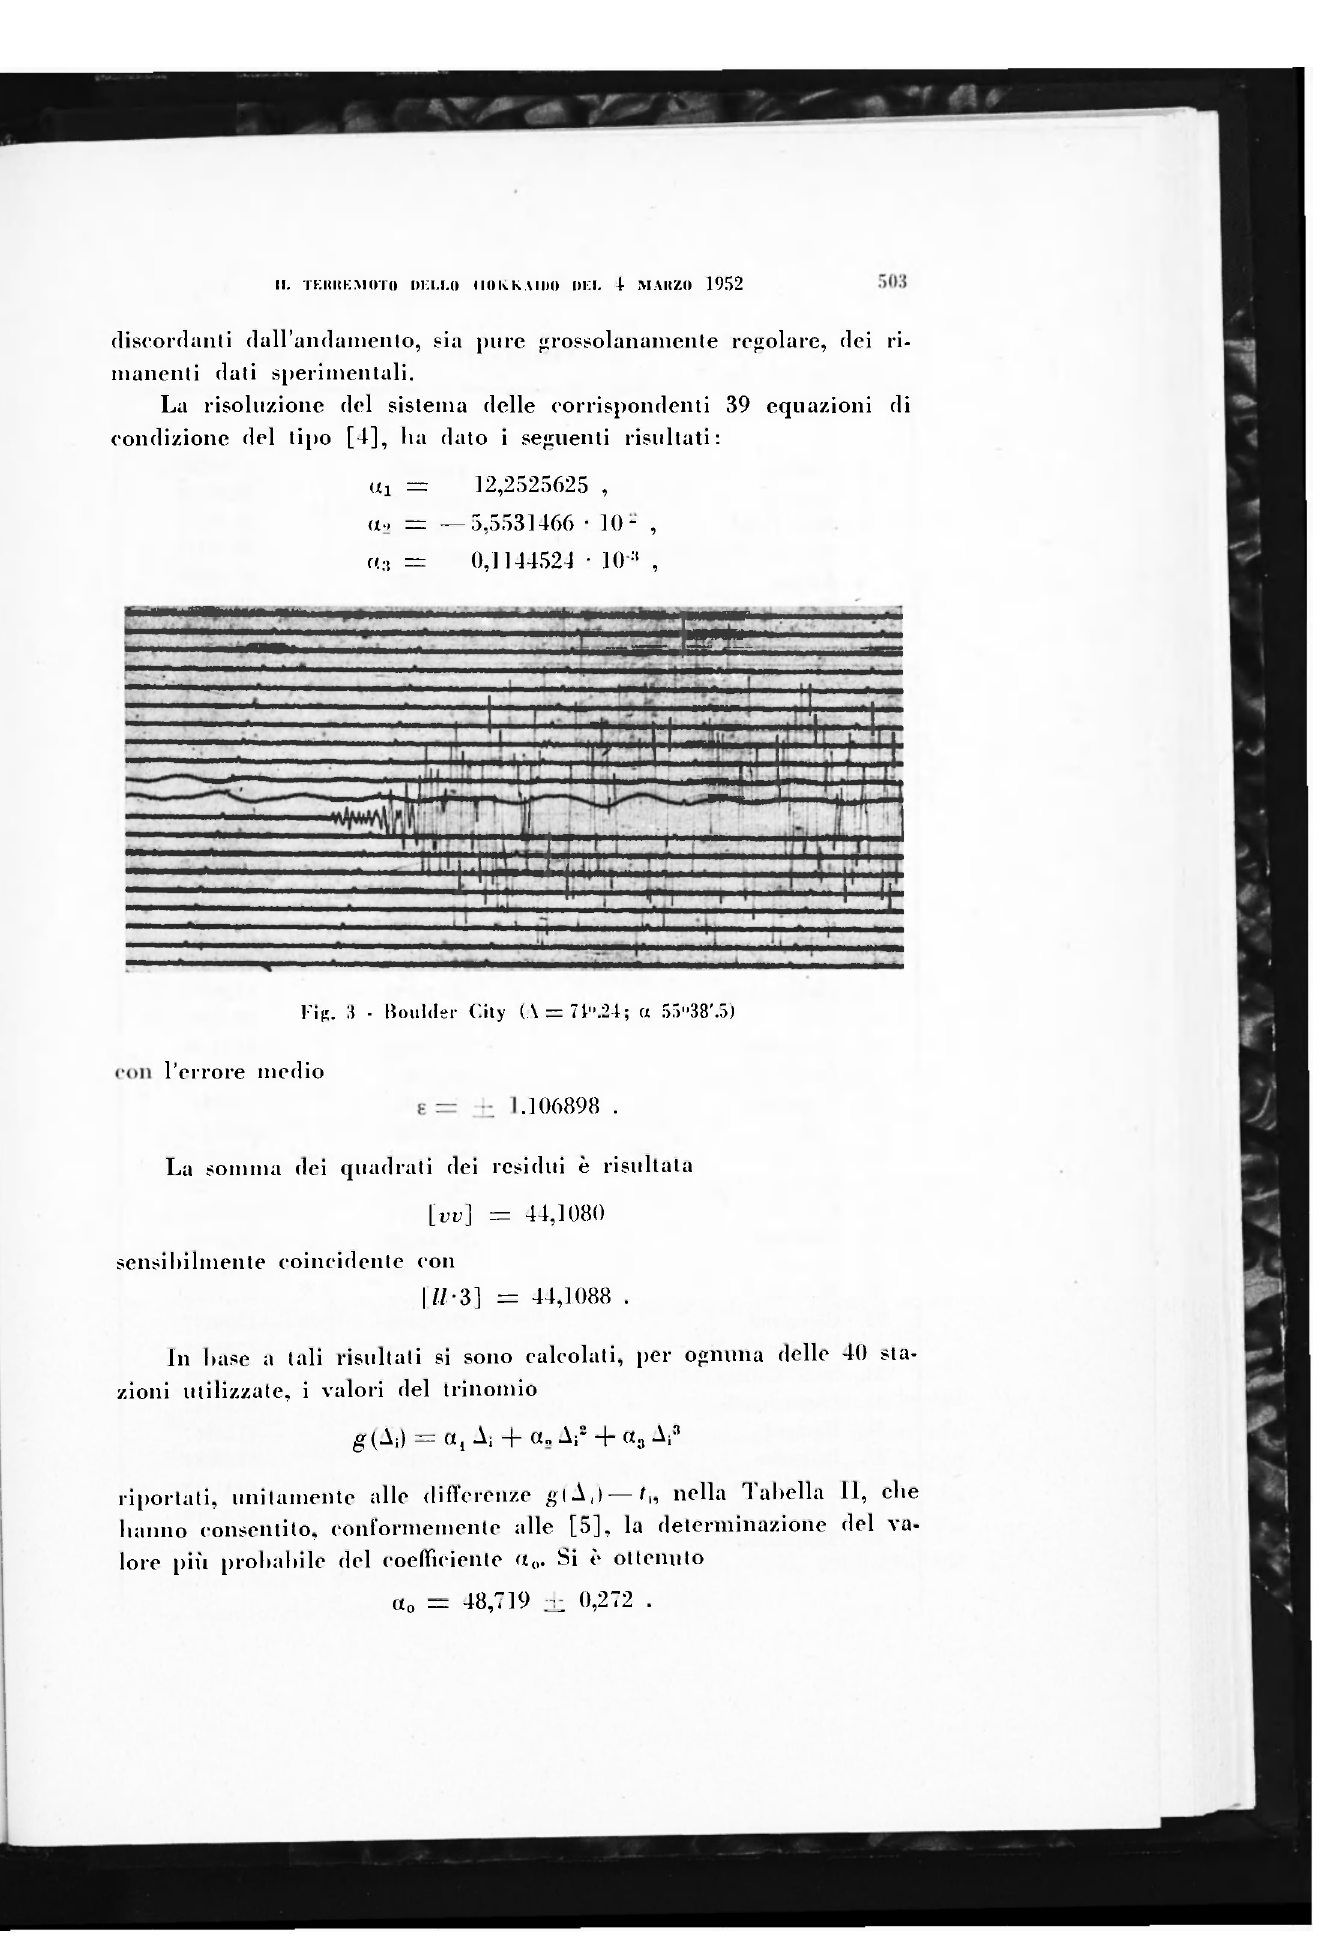
Fig. 3 - Boulder City (A = 71".24; a